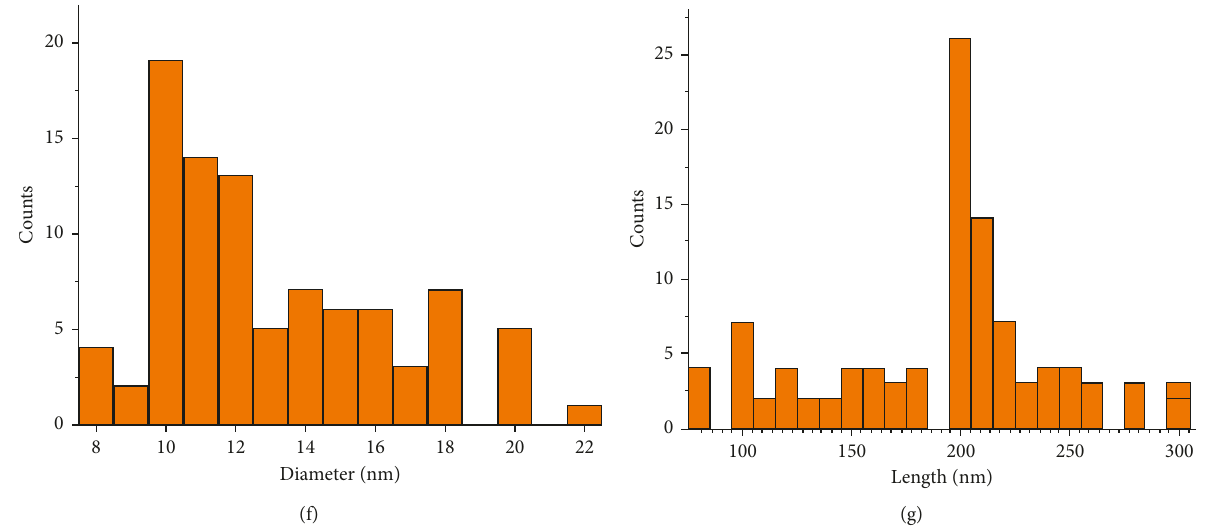
Figure 9: Schematic representation of laser-assisted fabrication of Bi nanostructures (a) in vacuum, (b) with matter-transport gas, and (c) in a liquid. (d) TEM image of a Bi nanorod produced by laser ablation and (e) its corresponding lattice fringes. (f) Diameter and (g) length distribution of the Bi nanorods [43]. Reprinted with permission from Reppert, Jason, “Laser-assisted synthesis and optical properties of bismuth nanorods” (2007), All Theses,